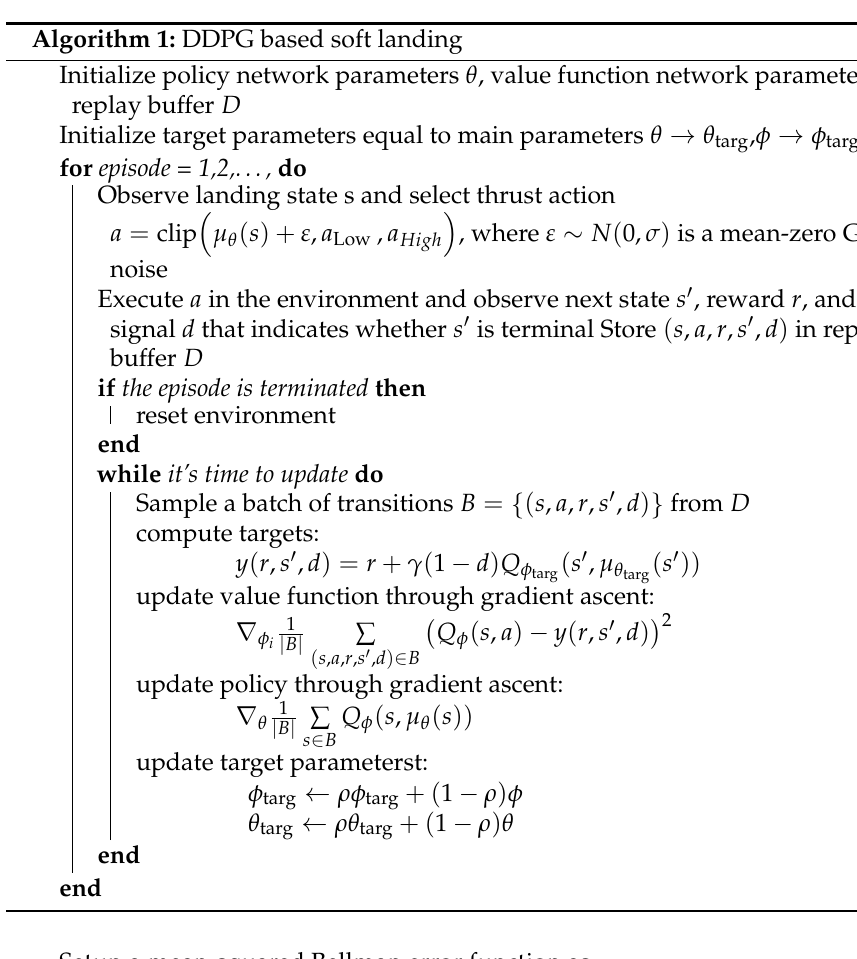
Algorithm 1: DDPG based soft